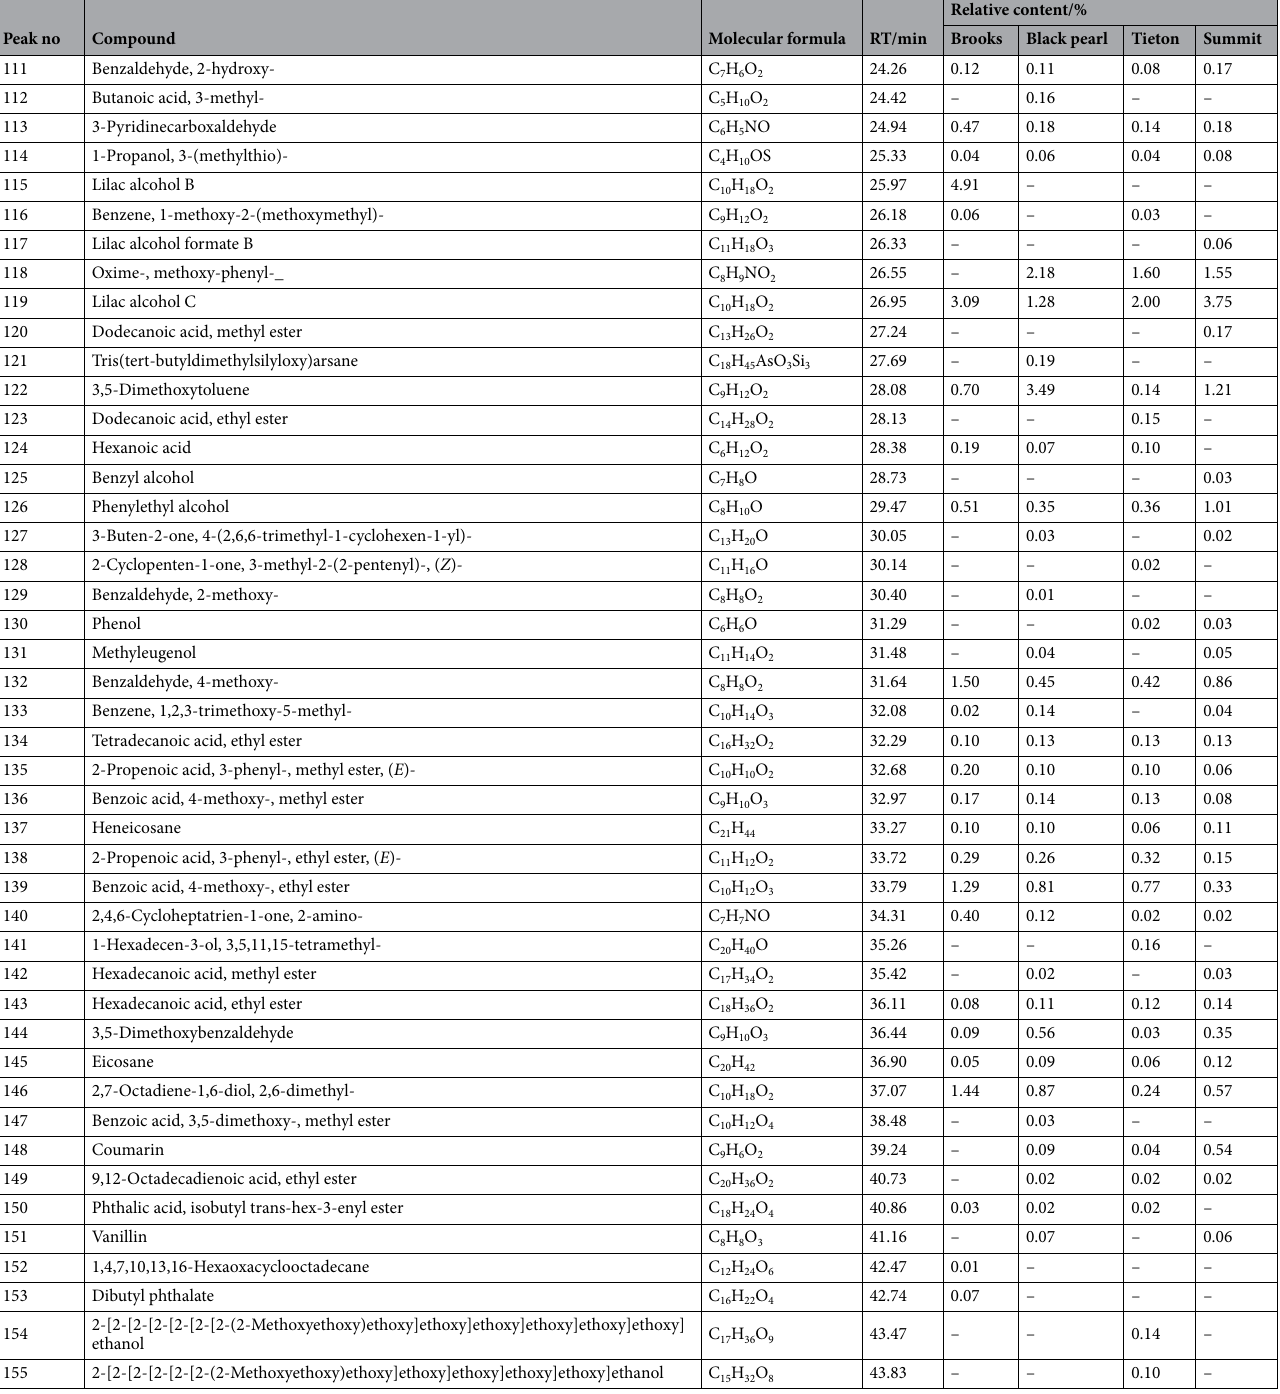
Table 6. Volatile organic compounds identified in four sweet cherry cultivar flower essential oils by HS-SPME/GC–MS. RT retention